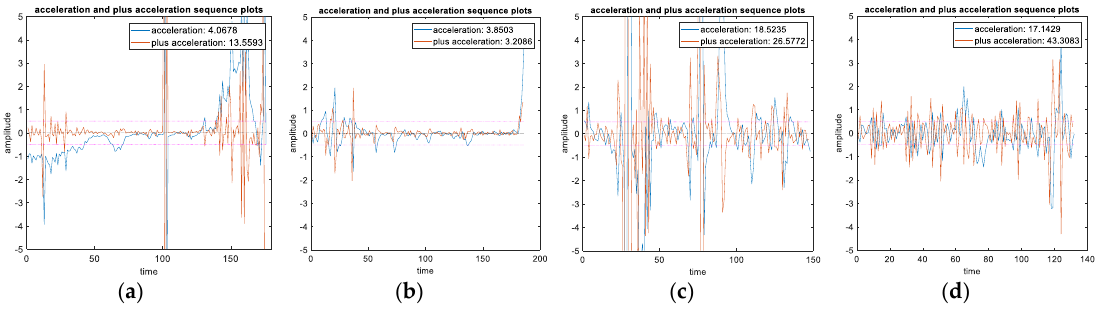
Figure 18. The measured acceleration and plus acceleration sequence plots. ( a ) Helicopter. ( b ) Rotary-wing UAV. ( c ) Fixed-wing UAV. ( d ) Bird.